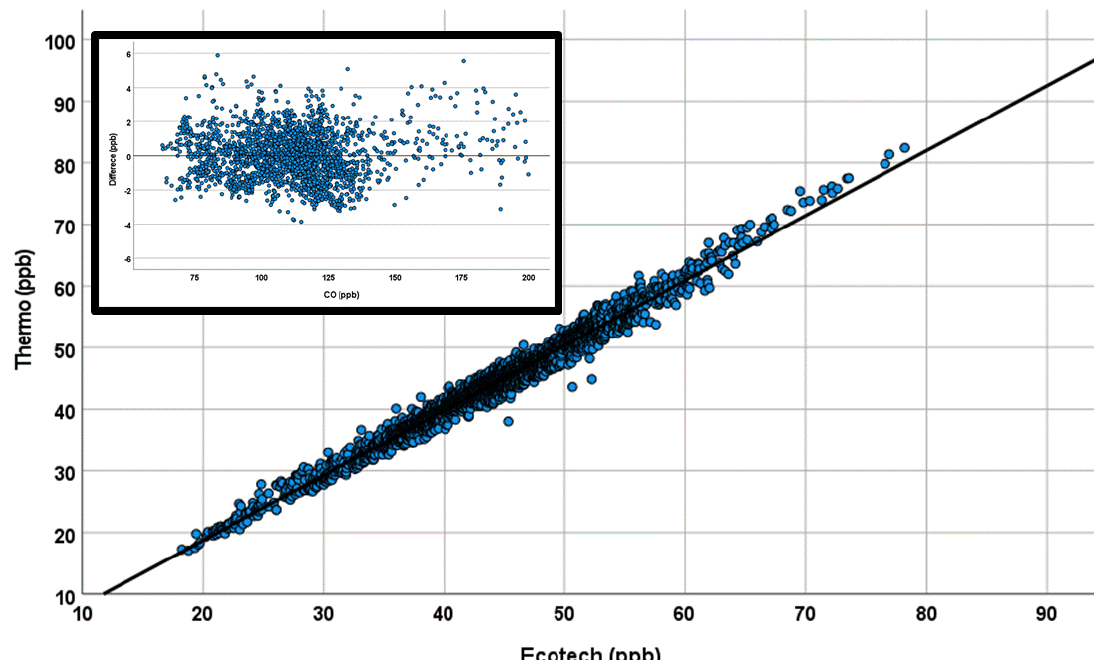
Figure 2. O 3 measured by the Thermo Fisher 49c instrument vs. Ecotech instrument at MBO during non-smoke periods (defined as CO < 200ppb). Data are hourly averages of all valid data for both instruments in 2020. The inset shows a difference plot (Thermo minus Ecotech) vs. CO for the same data. The root mean squared error (difference) of the Thermo vs. Ecotech plot is 0.9ppb, and the linear regression line has a slope of 1.055, a y intercept of − 2 . 4ppb, and an R 2 of